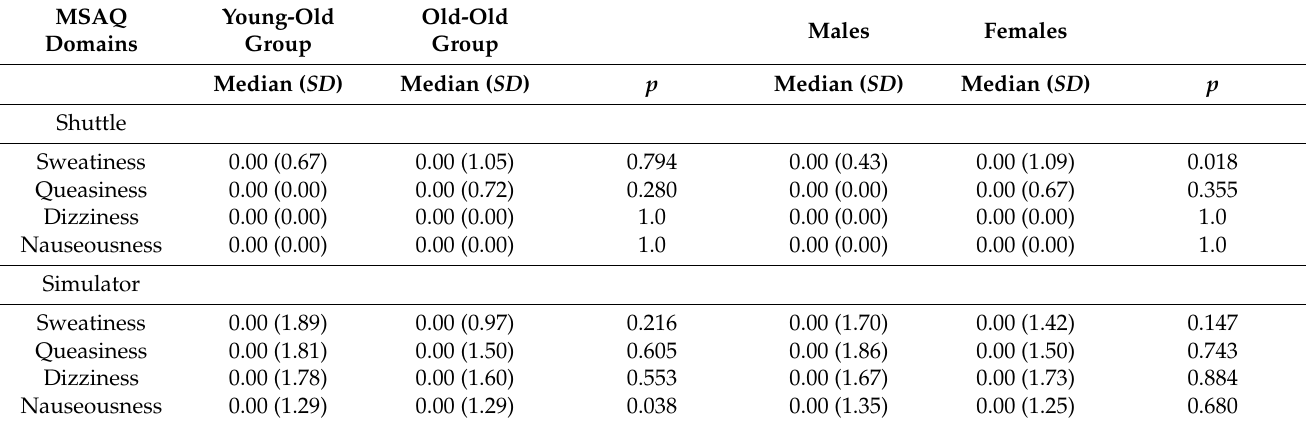
Table 3. Motion and Simulator Sickness Differences between Automated Shuttle and Driving Simulator Groups by Age and Sex.